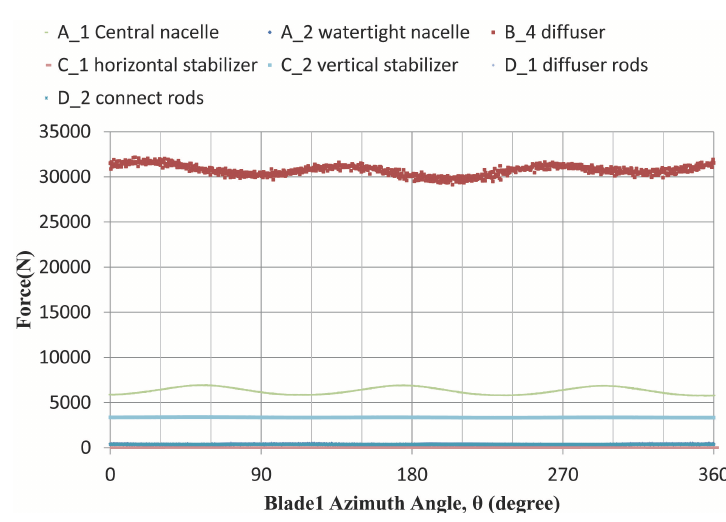
Figure 10. Forces imposed on each turbine component in the y -axis direction.